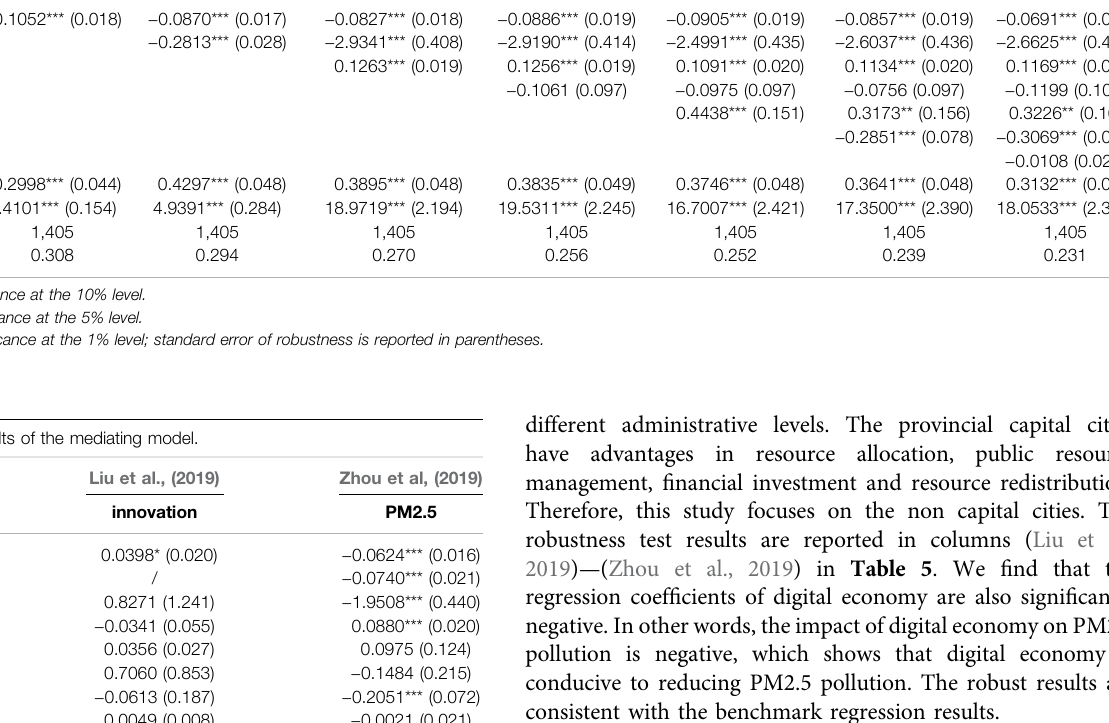
TABLE 2 | Regression of digital economy on PM2.5 pollution.